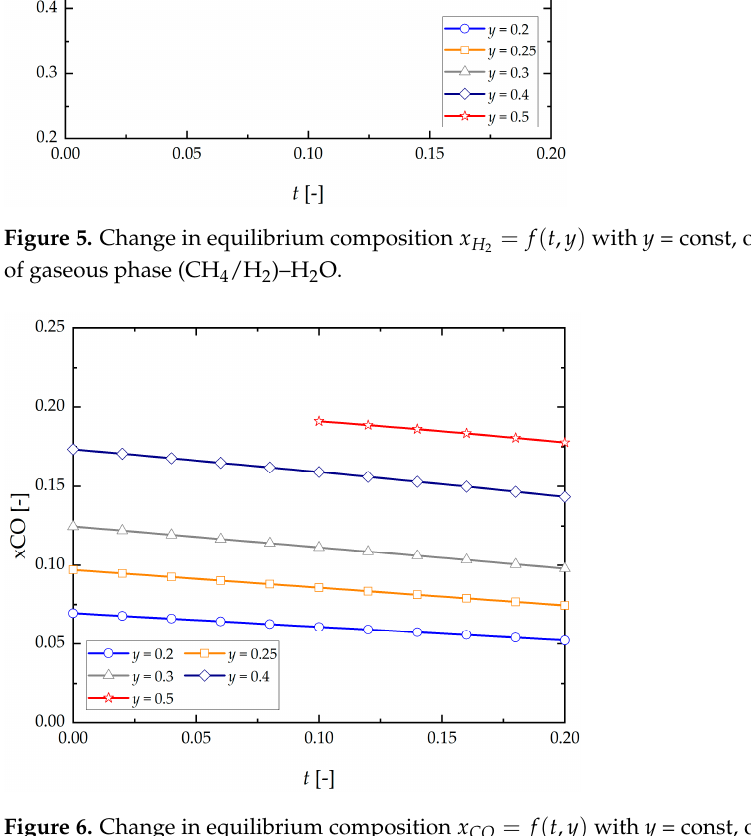
Figure 6. Change in equilibrium composition x CO = f ( t , y ) with y = const, of the reforming process of gaseous phase (CH 4 /H 2 )–H 2 O.